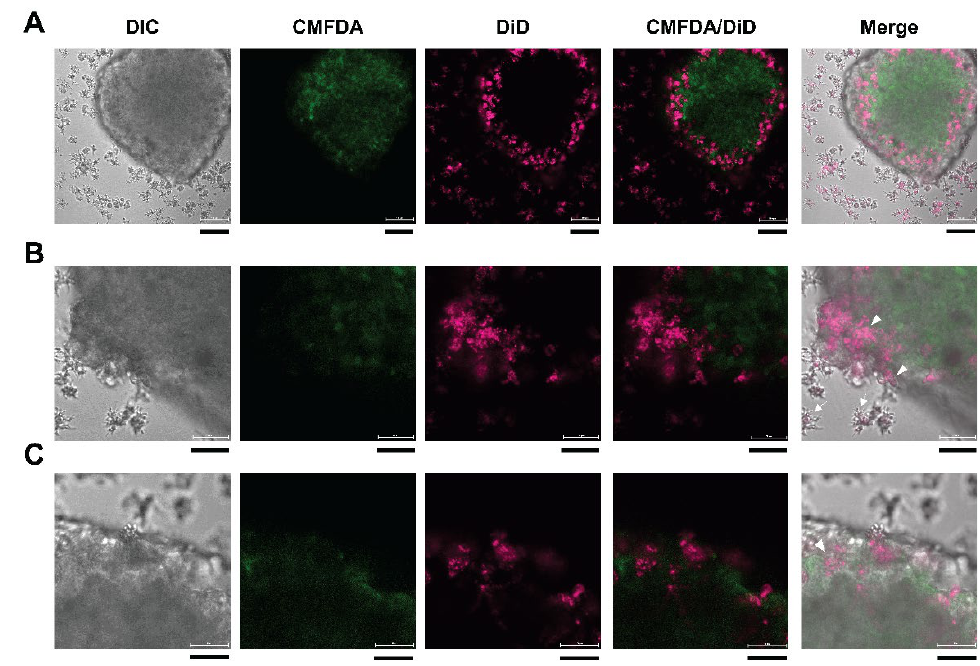
Figure 4. Fluorescence images of the B. mandrillaris trophozoites cocultured with human neuro- spheroid. ( A ) A top view of the neurospheroid. Scale bar = 100 µ m. ( B ) Higher magnification at the edge of the neurospheroid. Scale bar = 50 µ m. ( C ) Invasion of the trophozoites into